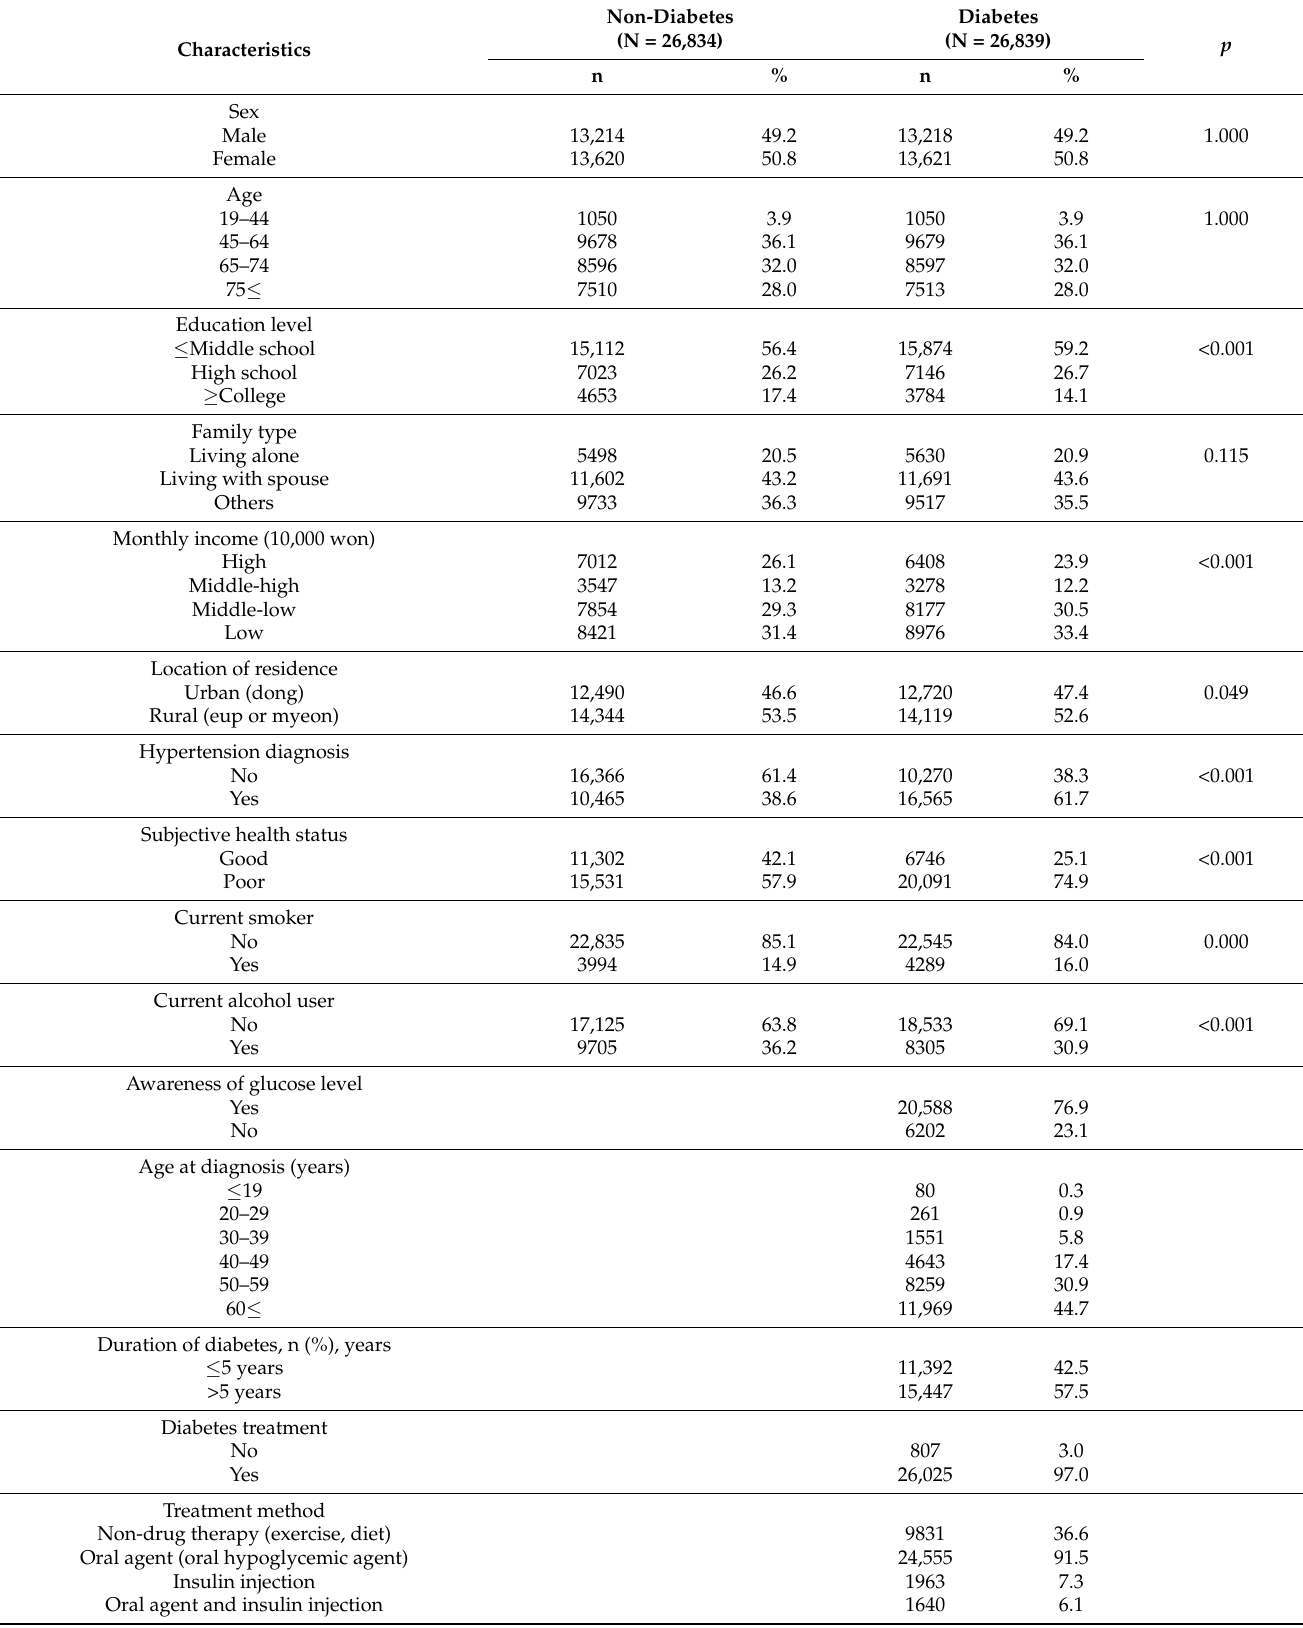
Table 1. Characteristics of diabetes and control